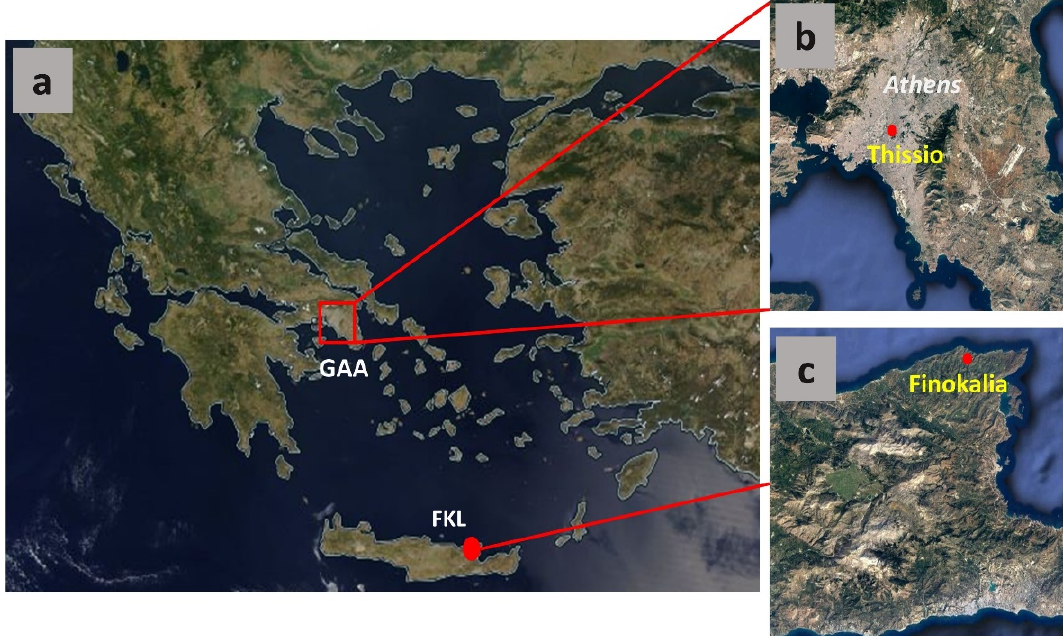
Figure 1. Overview of the study region ( a ). Locations of the Thissio urban background site, within the Greater Athens Area (GAA— b ) , and the Finokalia (FKL— c ) regional background site, on the island of Crete. Taken from Google Earth.